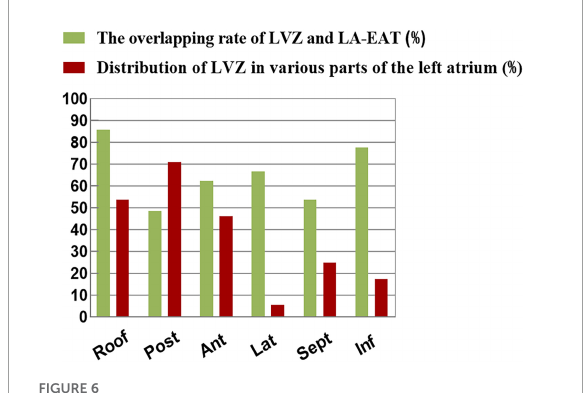
FIGURE6 The distribution of LVZ in each segment of the left atrium and the consistency of overlap with